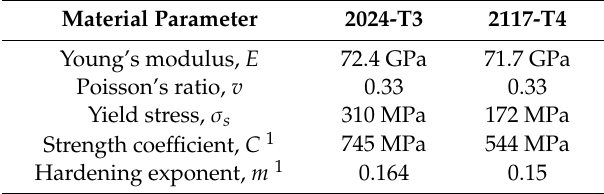
Table 2. Material properties for 2024-T3 plates and 2117-T4 rivets [20].